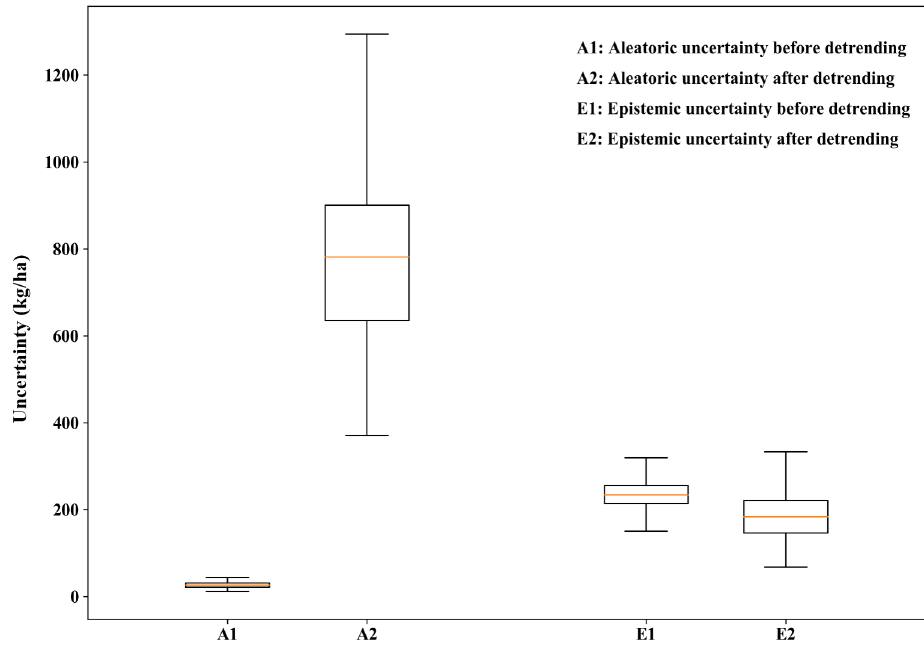
Figure 12. Uncertainty changes before and after detrending